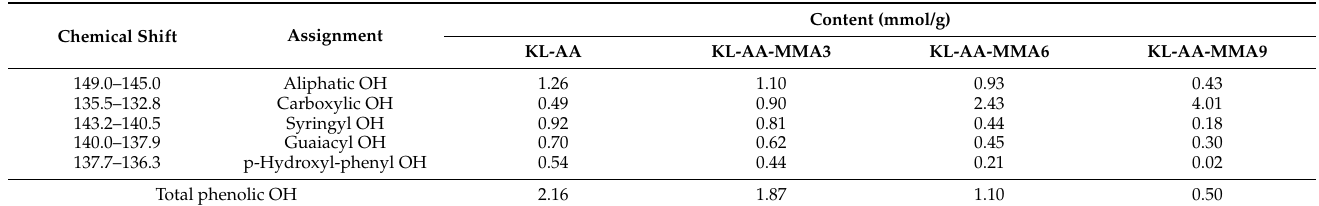
Table 2. Hydroxyl group contents of the KL-AA and KL-AA-MMA copolymers calculated from 31 P-NMR spectra (Figure 2).